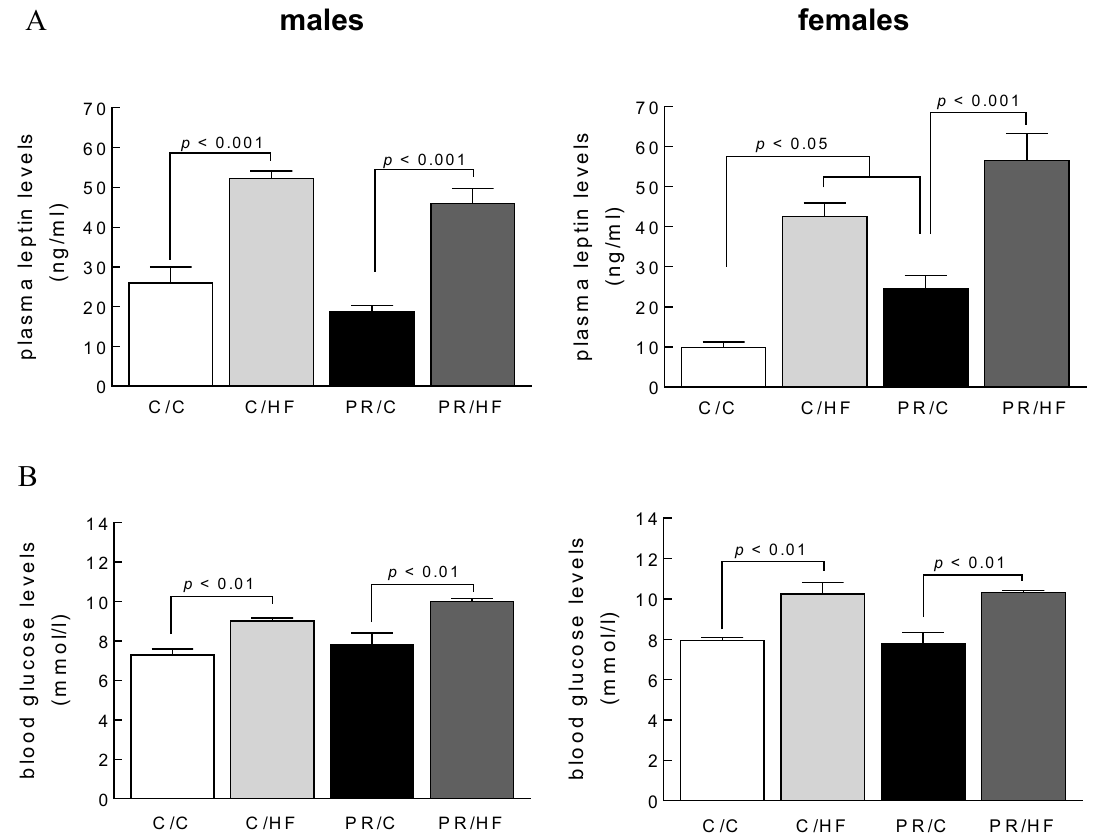
Figure 3. ( A ) Plasma leptin levels and ( B ) Blood glucose levels in male in male and female offspring Figure 3. (A) Plasma leptin levels and (B) Blood glucose levels in male and female from dams on standard on standard chow (C) or protein restricted (PR) diet during pregnancy. offspring from dams on standard chow (C) or protein restricted (PR) diet during Weaned offspring were then fed either a high fat (HF) or C diet to adulthood, thus generating the dam/offspring dietary group: C/C, C/HF, PR/C and PR/HF. All values are reported as means ± SME pregnancy. Weaned offspring were then fed either a high fat (HF) or C diet to adulthood, ( n = 7–11 per group) and analyzed using a one-way ANOVA with Turkey-Kramer post hoc thus generating the dam/offspring dietary groups: C/C, C/HF, PR/C and PR/HF. All values are reported as means ± SEM. (n = 7–11 per group) and analysed using a one-way ANOVA with Tukey–Kramer post hoc test.